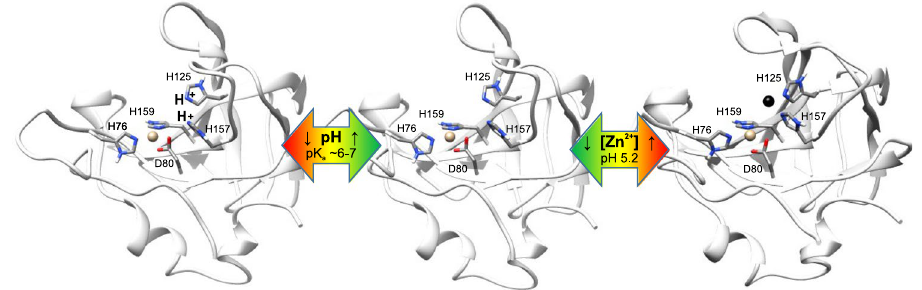
Figure 8. The constraints of LytU catalysis by inactivation with pH and zinc ions. Three structures of LytU catalytic domain are presented to the viewer peering through substrate binding groove (upper left in all three structures) with the site of catalysis at the proximal end. The key conserved residues are indicated. H76, D80 and H159 coordinate zinc (tan sphere) mandatory for substrate cleavage. Catalytic H157 and H125 reside nearby and are subjects to one of three fates. The block arrows indicate the driving forces in respective transitions and their gradient colour emphasizes positive (green) or negative (red) effect on LytU catalytic potential. The enzyme is in an active form (centre) and rapidly loses its activity (left) with decreasing pH (Supplementary Fig. S5). This is consistent with the protonation of H125 and H157. On the other hand, a second zinc ion (black sphere, right) may also bind LytU with a submicromolar dissociation constant (Supplementary Figs S6, S7 and Supplementary Table S2) and it is coordinated by N ε 2 of the H125 and H157 (Supplementary Fig. S6). Consequently, this binding is catalytically inhibitory. Supplementary Fig. S10 provides a close-up look at the tautomeric forms of